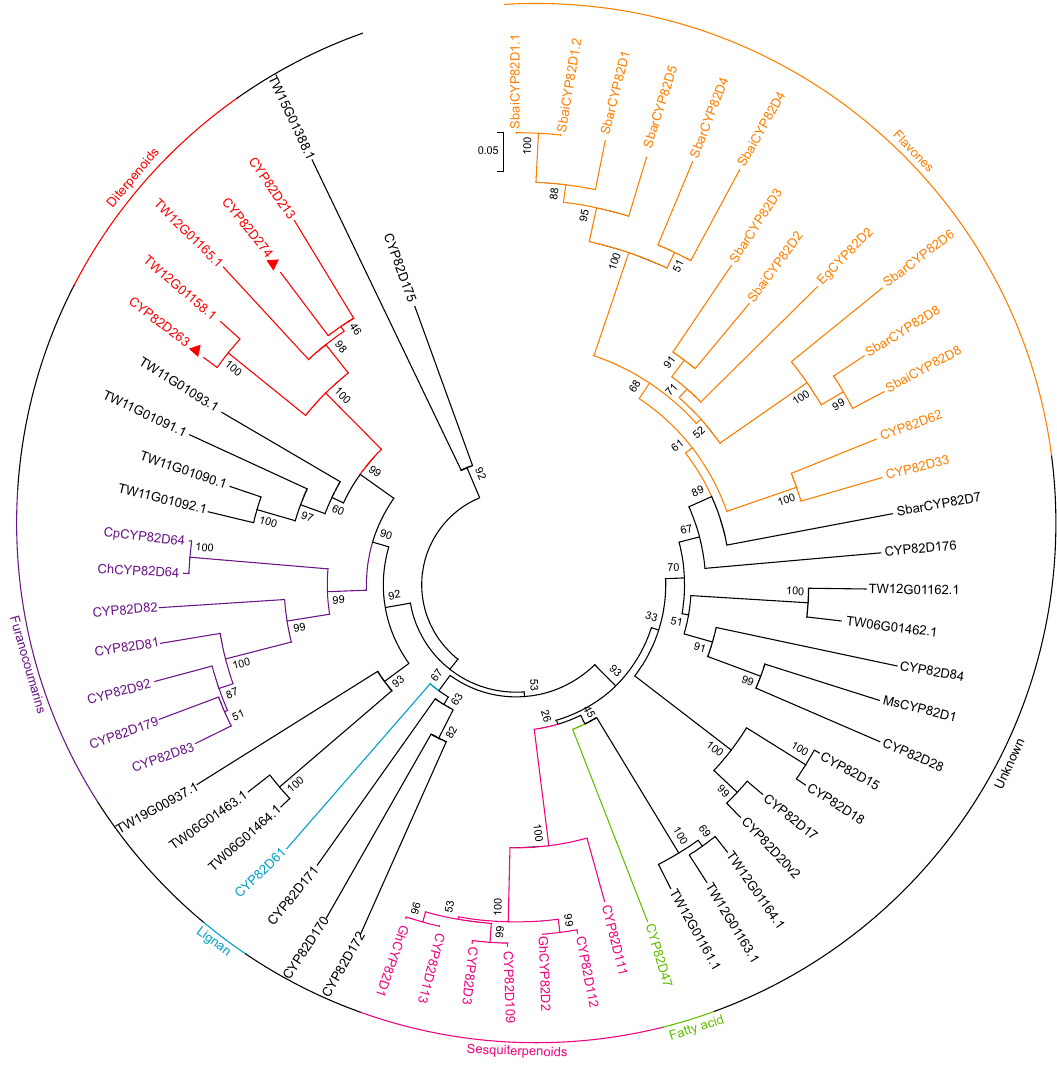
Fig. 7| Phylogenetic analysisofCYP82Ds. Atotalof 61CYP82Ds from fl avonoids, furanocoumarins, lignan, fatty acid, sesquiterpenoids, diterpenoids, etc., were included and indicated by different colors. Phylogenetic analysis was performed